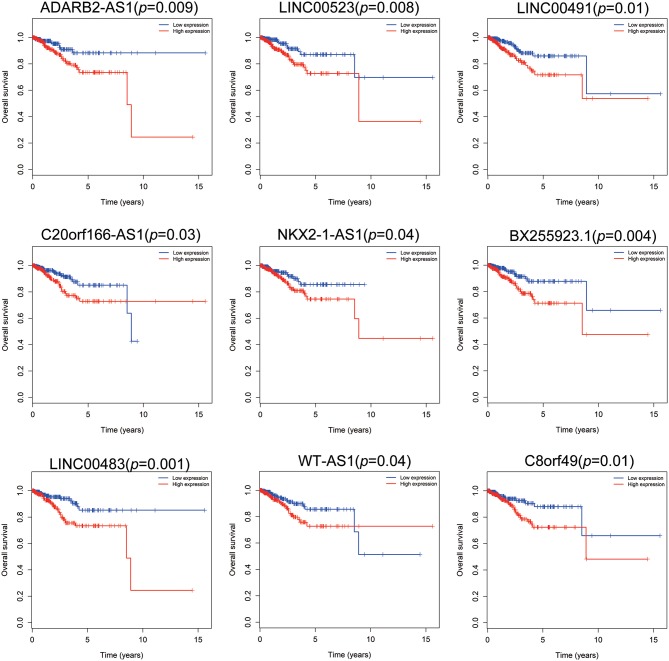
Survival analysis of nine lncRNAs. Red plot indicates overexpression, while the blue plot represents low expression. Univariate Cox regression analysis was used to identify the lncRNA with prognostic value.